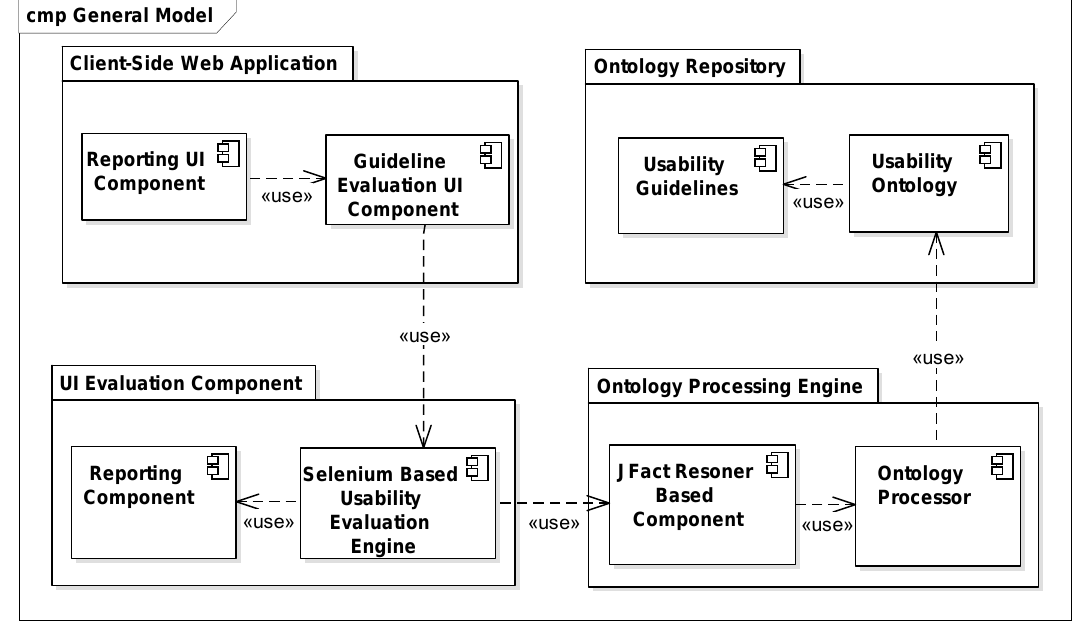
Figure 1. High-level architecture of